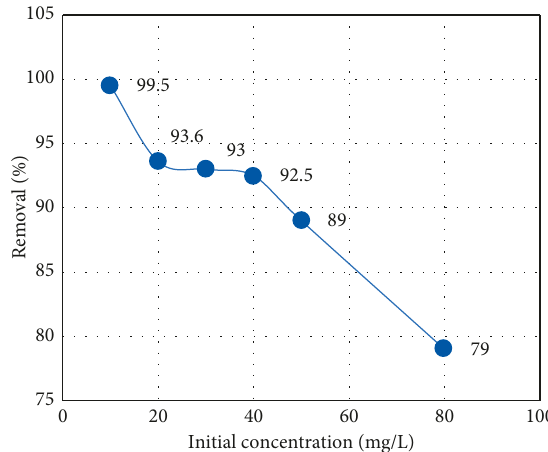
Figure 9: Influence of initial dye concentration on the adsorption of EBT dye by 0.1g/50 mL NSG nanocomposite at a pH of 3 and a contact time of 20min.